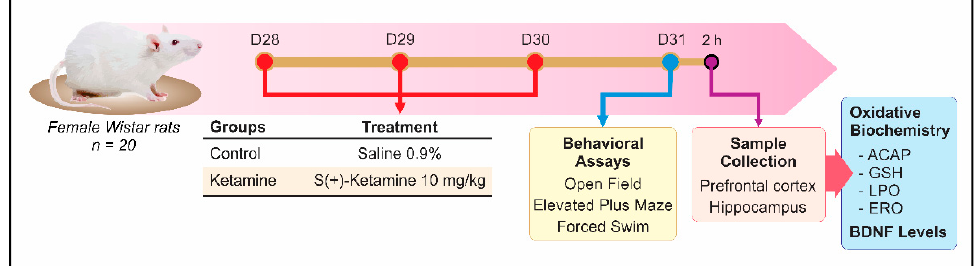
Figure 1. Experimental study design. Adolescent rats (28 to 30 days old) received saline or ketamine (10 mg/kg/day) intraperitoneally for 3 consecutive days. Twenty-four hours after the last administration, animals were sequentially submitted to open field, elevated plus maze, and forced swimming behavioral tests. Two hours after the behavioral tests, animals were anesthetized and euthanized for biological sample collection for biochemical assays.